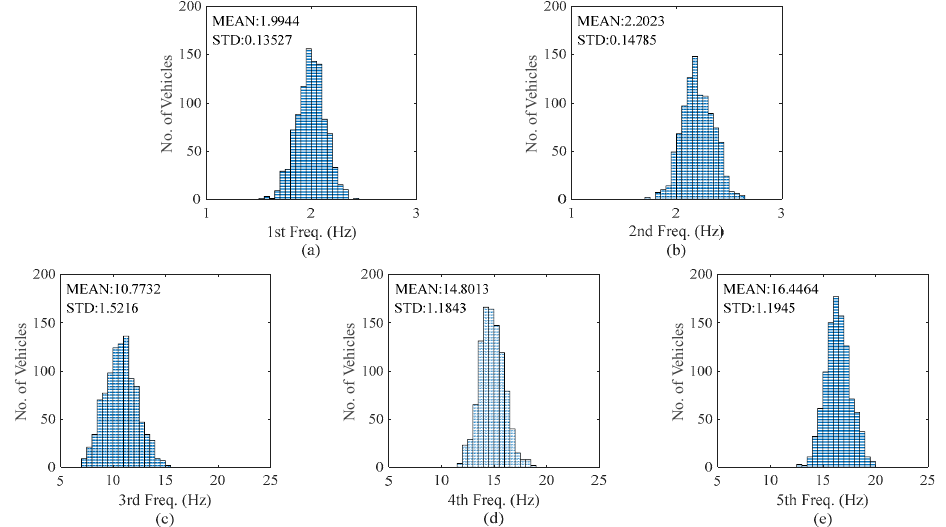
pitch vary between 1.5 and 3 Hz (as Figure 2a,b), and frequencies for the rear tandem hop and pitch and the front axle hop are found between 7 and 20 Hz (as Figure 2c–e).